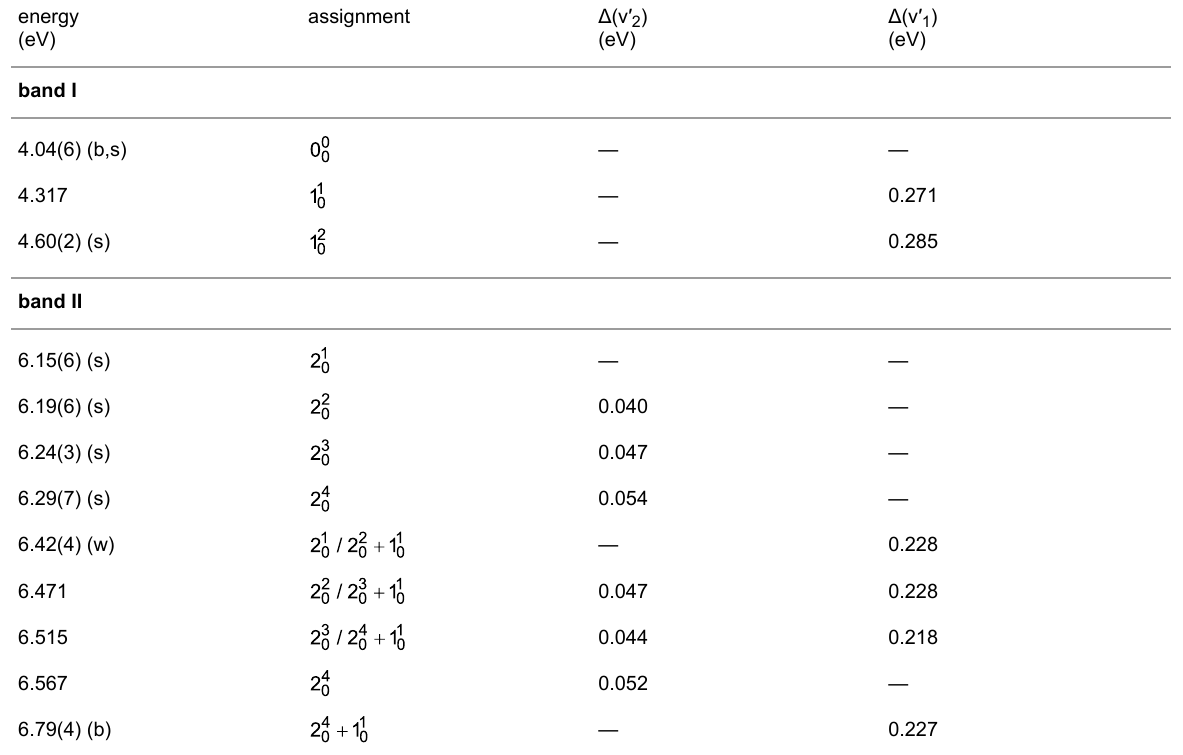
Table 2: Proposed vibrational assignments in the 4.0 − 9.0 eV absorption bands of W(CO) 6 . (b) broad structure; (s) shoulder structure; (w) weak fea- ture. The last decimal of the energy value is given in brackets for these less-resolved features). energy assignment (eV)